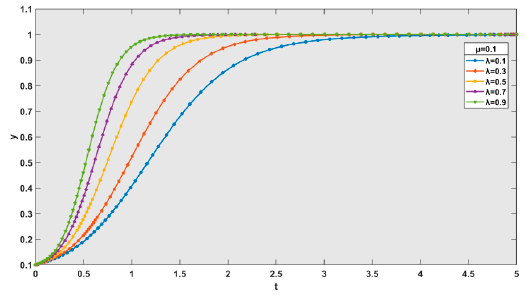
Figure 11. The combination strategy of λ and μ on the system’s evolution trajectory.